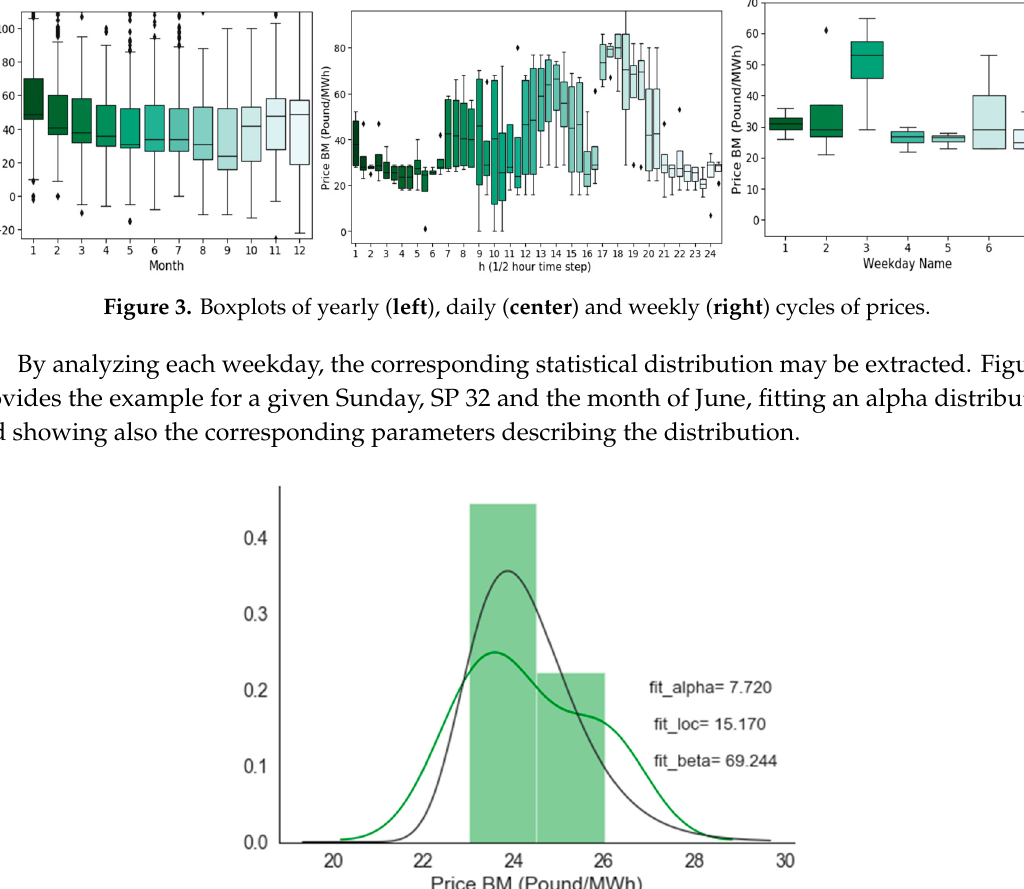
Figure 2. Correlation matrix of input variables. It can be observed that there is high correlation between some LOLP variables with different time horizons and also DRM variables as expected. However, since the model is to be run several times until 1 h ahead of the closing gate, in order to provide as accurate estimations as soon as possible, the model will take into account all of these predictors. Additionally, the high correlation between production and demand stands out, which is because one should match the other at all times. The reason for keeping both of the variables is to capture any deviations between the two, which could exist and maybe have an impact on the target variable.